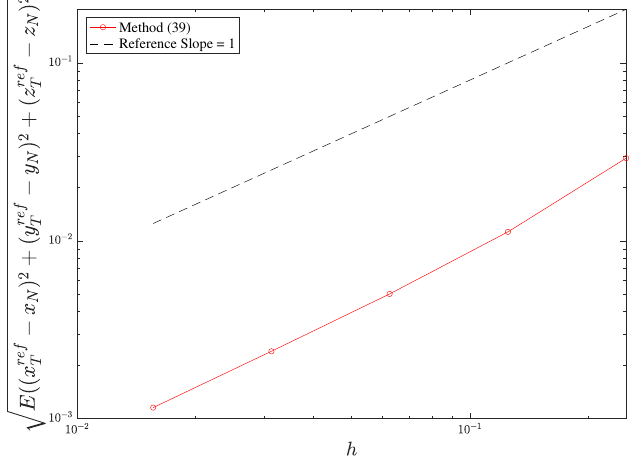
Figure 2. Convergence order for Example